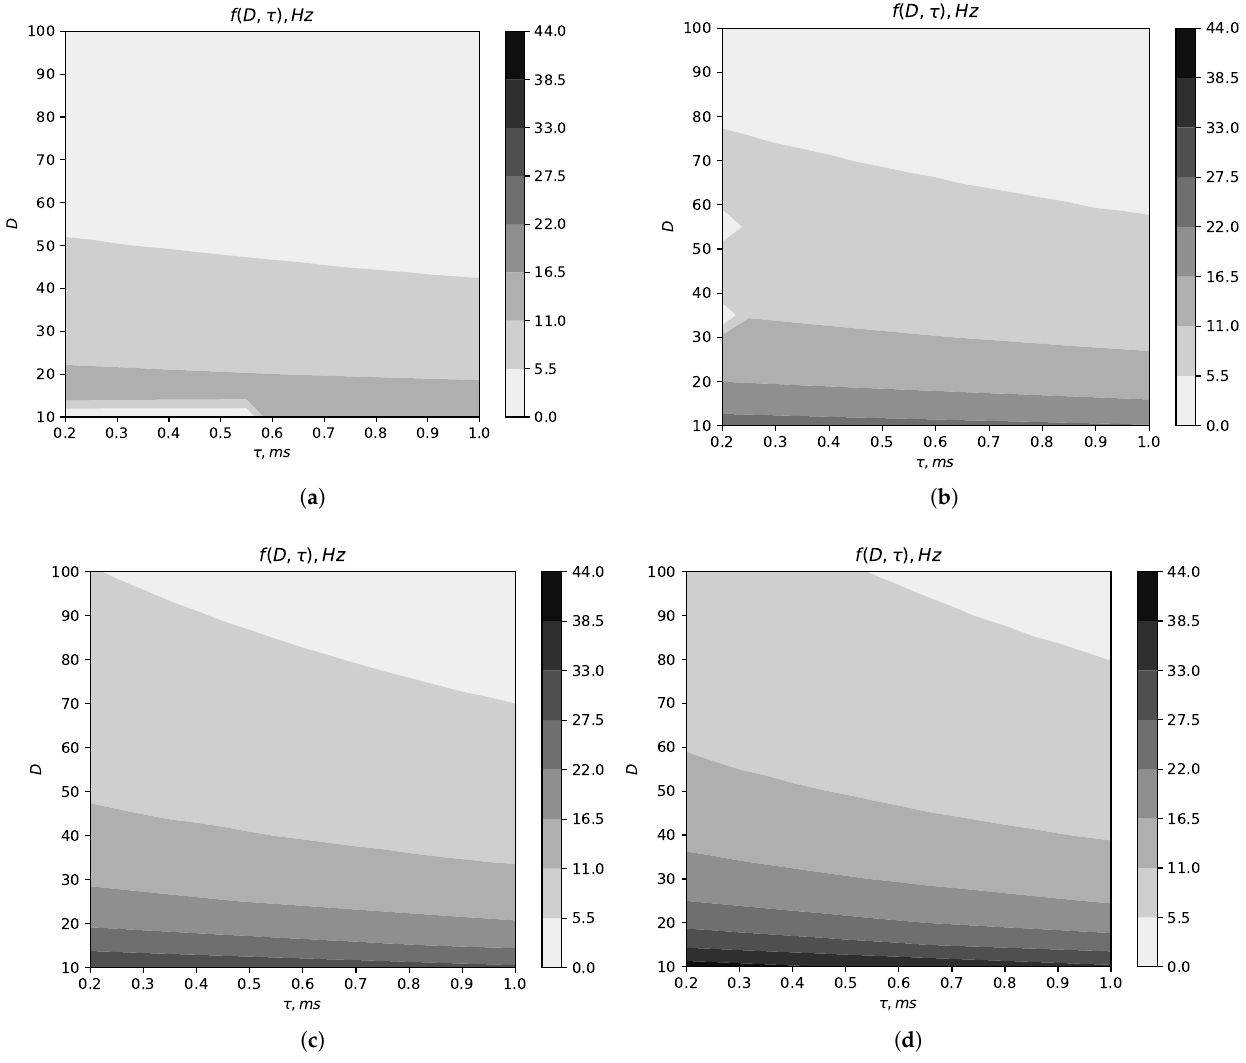
Figure 3. Dependence of the frequency f on the number of neuron-like oscillators and coupling delay time for different values of the coupling coefficient: k = 30 ( a ), k = 40 ( b ), k = 50 ( c ) and k = 60 ( d )